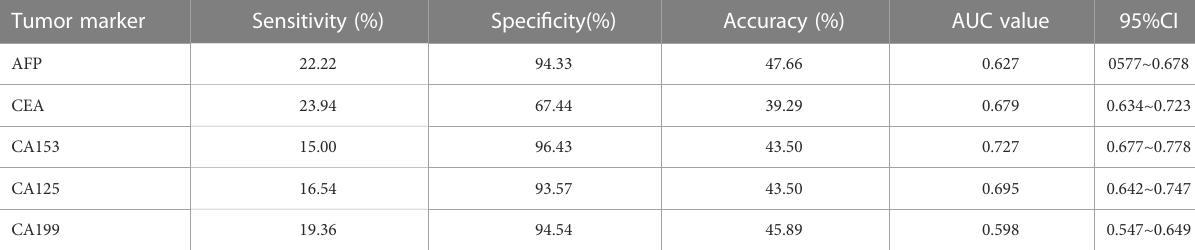
TABLE 3 Results of single detection of 5 tumor markers. Tumor